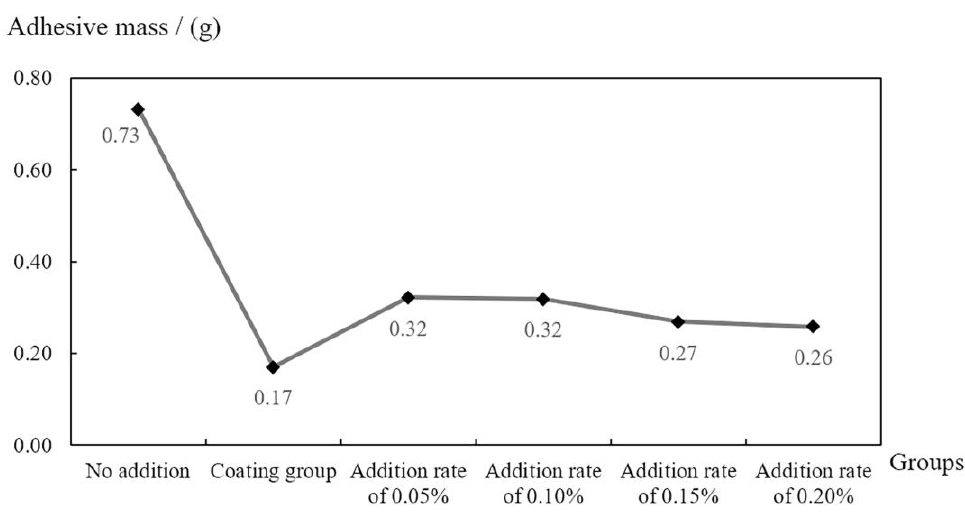
Figure 10. Mean values of the mass of biological organisms for each group.